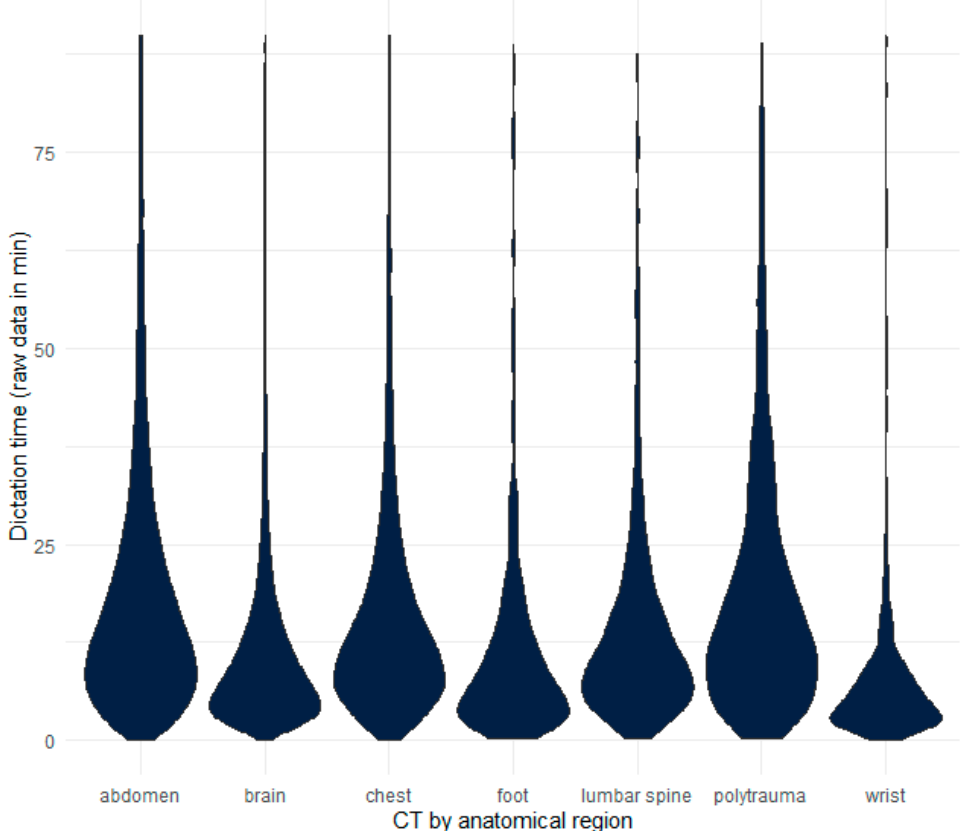
Figure 1. Violin chart shows all CT dictation times by anatomical regions from 05/2010 until 01/2021 before simulation for outlier reduction. For better clarity, longer time entries in the graph (>80 min) were not taken into account. Note that the charts seem to be truncated, which is caused by outliers with short time entries, e.g., by initially caching the report after starting the dictation software. Nevertheless, the data seem to be normally distributed, which can only be explained by the proportion of the actual radiological reading time.